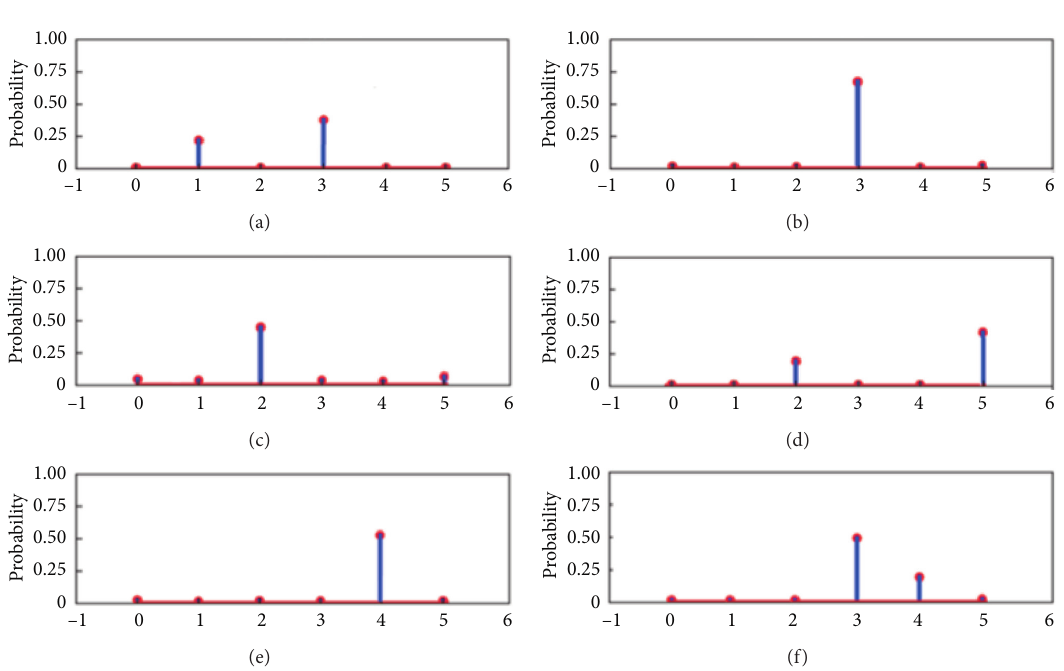
Figure 3: Document-topic distribution. (a) Topic, document 50. (b) Topic, document 61. (c) Topic, document 24. (d) Topic, document 39. (e) Topic, document 46. (f) Topic, document 45.